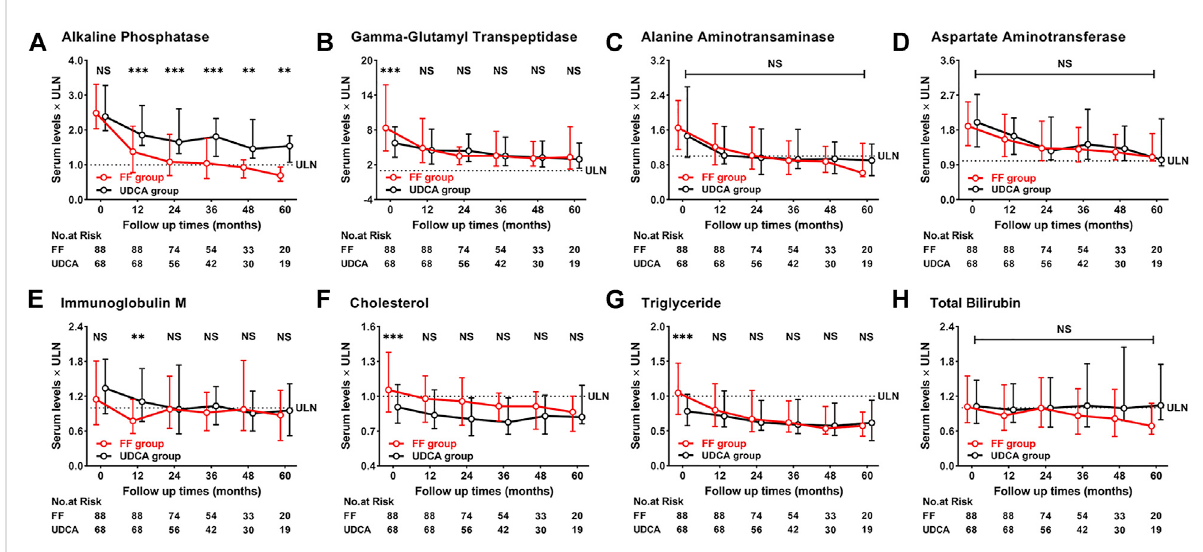
FIGURE 9 Dynamic changes of parameters with follow-up time (A) Alkaline Phosphatase (B) Gamma-Glutamyl Transpeptidase (C) Alanine Aminotransferase (D) Aspartate Aminotransferase (E) Immunoglobulin M (F) Cholesterol (G) Triglyceride (H) Total Bilirubin. Group, patients with UDCA-refractory PBC treated with UDCA + FF (the FF group) or UDCA (the UDCA group). Shown are the median values and interquartile ranges at each follow-up visit. Data was compared with the Mann – Whitney U test. Abbreviations: UDCA, ursodeoxycholic acid; FF, feno fi brate; ULN, upper limit of the normal range; LLN, lower limit of the normal range.